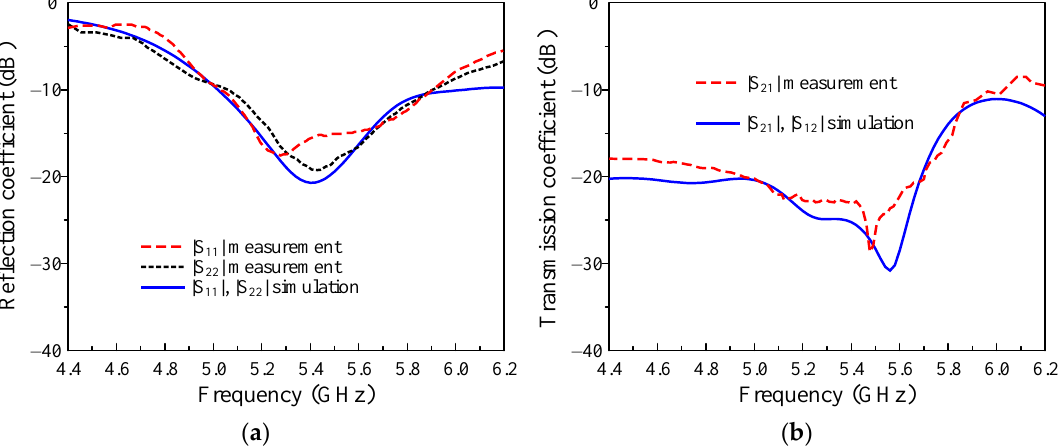
Figure 12. Simulated and measured S-parameter of the proposed MIMO antenna. ( a ) Reflection co- efficient (|S 11 |), ( b ) transmission coefficient (|S 21 |).